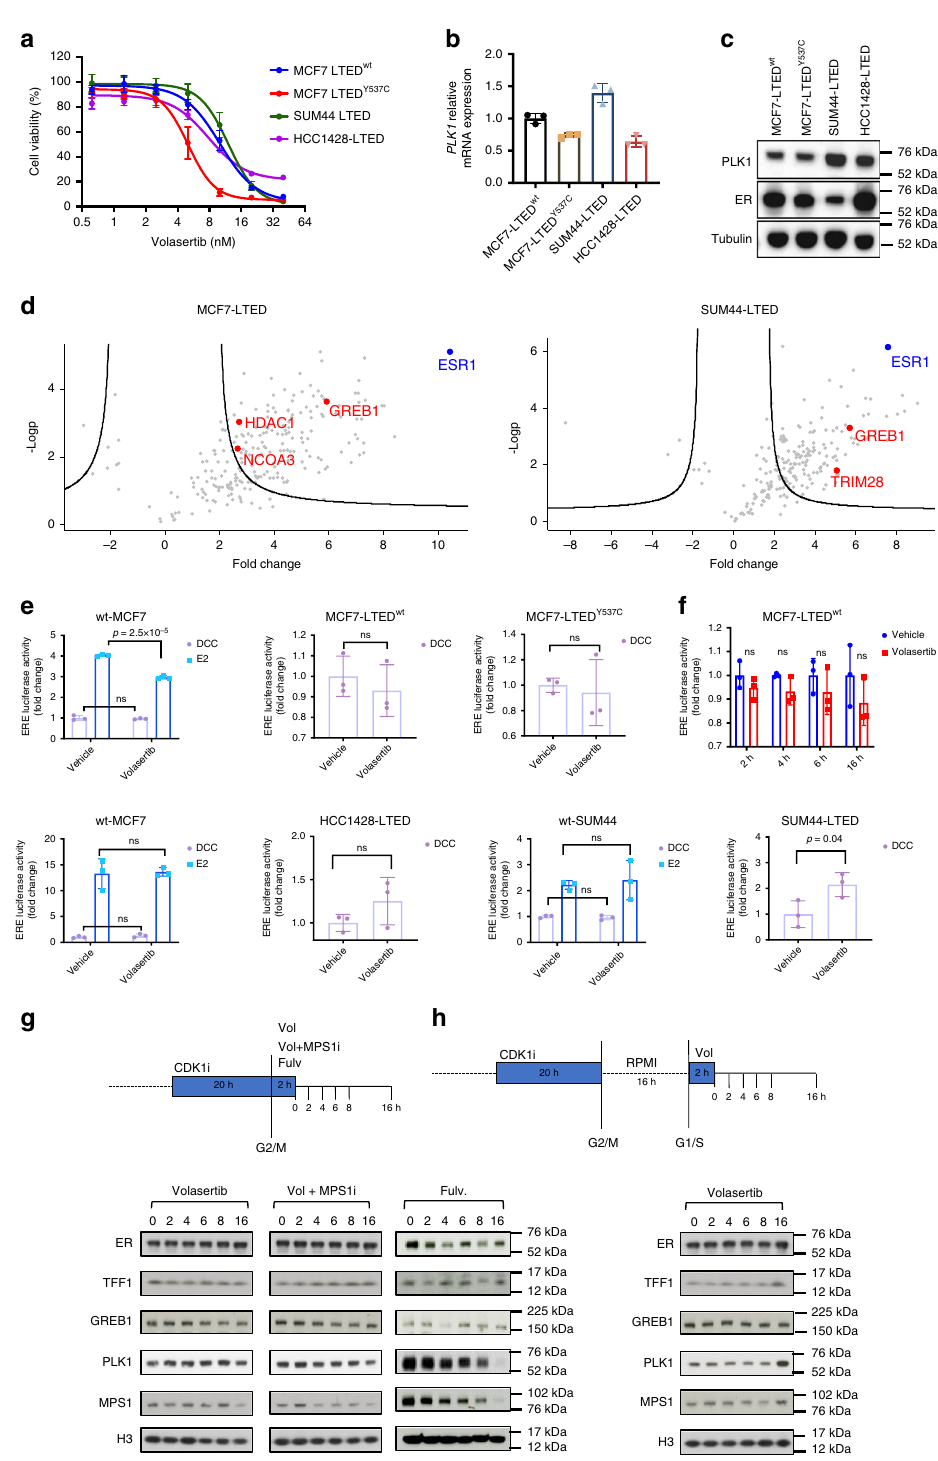
(Fig. 6a). MCF7-LTED Y537C were the most sensitive with an IC 50 of 5 nM compared with MCF7-LTED wt , HCC1428-LTED and SUM44-LTED which had IC 50 values between 10 and 16 nM.